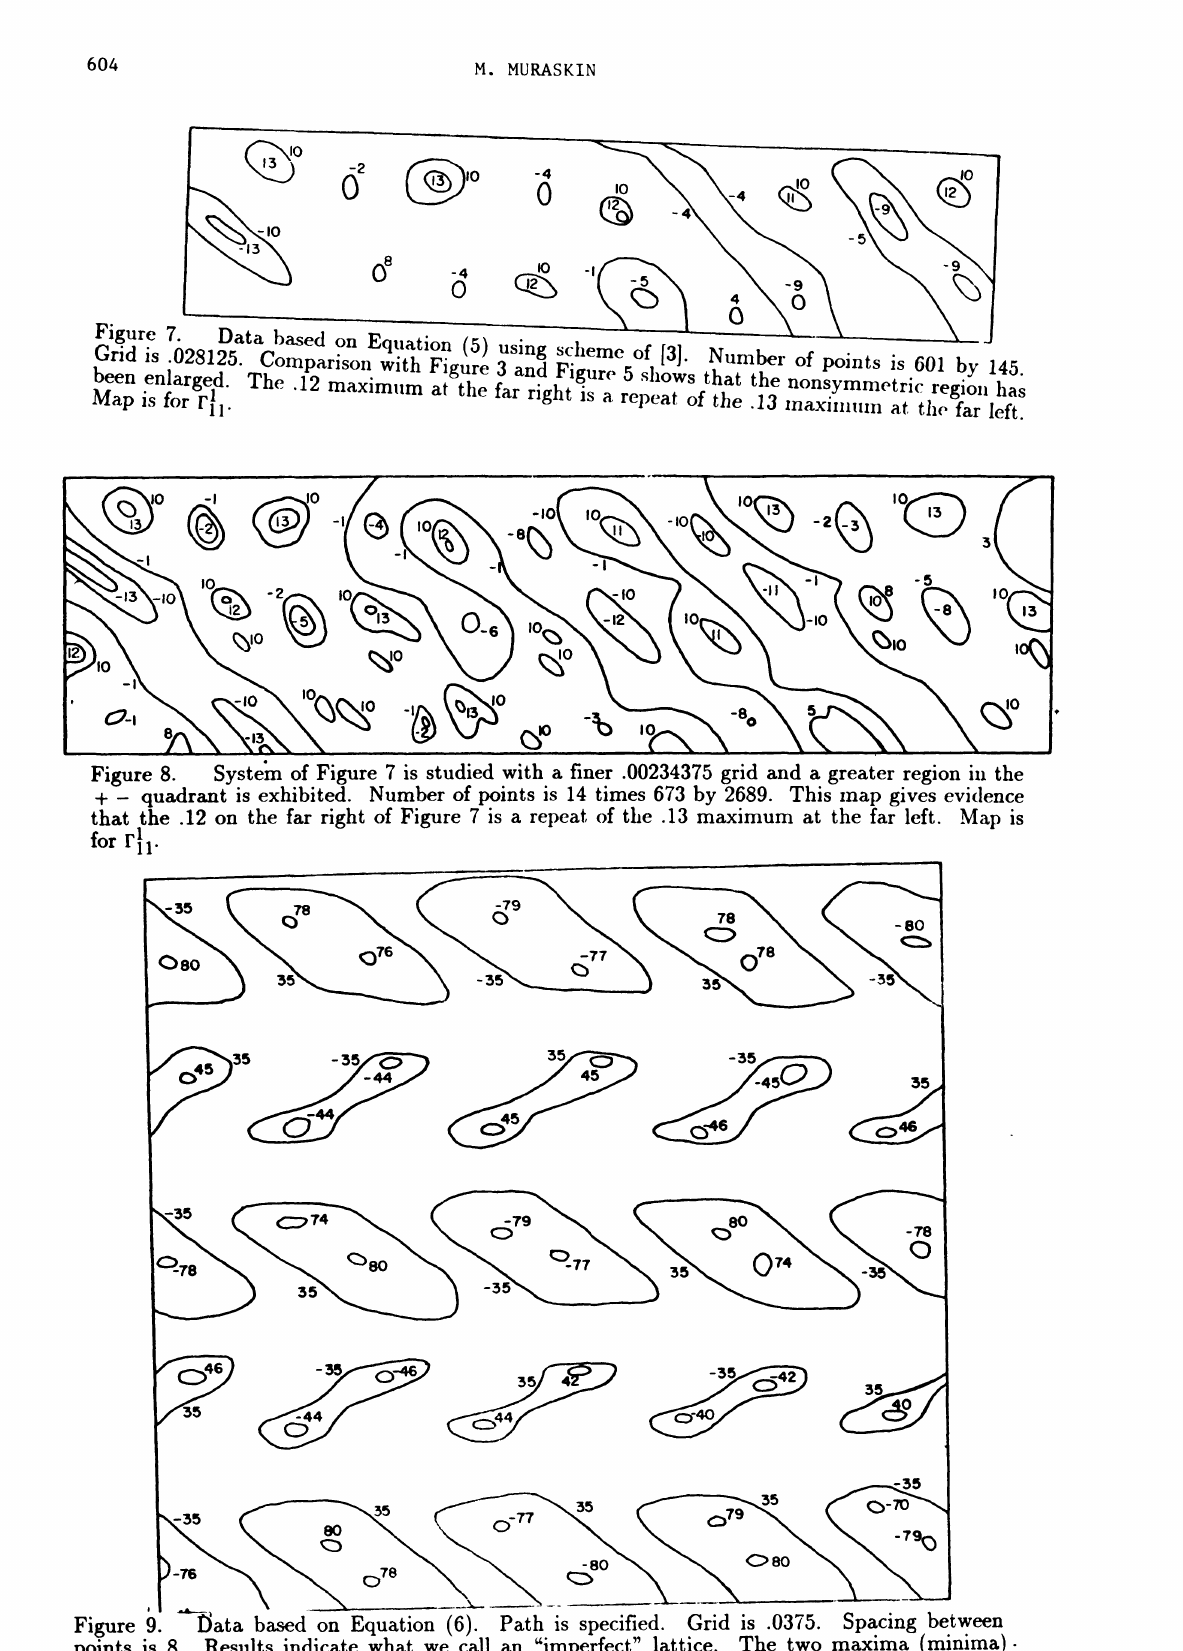
o o Figure 7. Data based on Equation (5) using scheme of [3]. Grid is .028125. Comparison with Figure 3 and Figure 5 shows been enlarged. The .12 maximum at the far right Map is for FI. "-L 0 ligure 8.